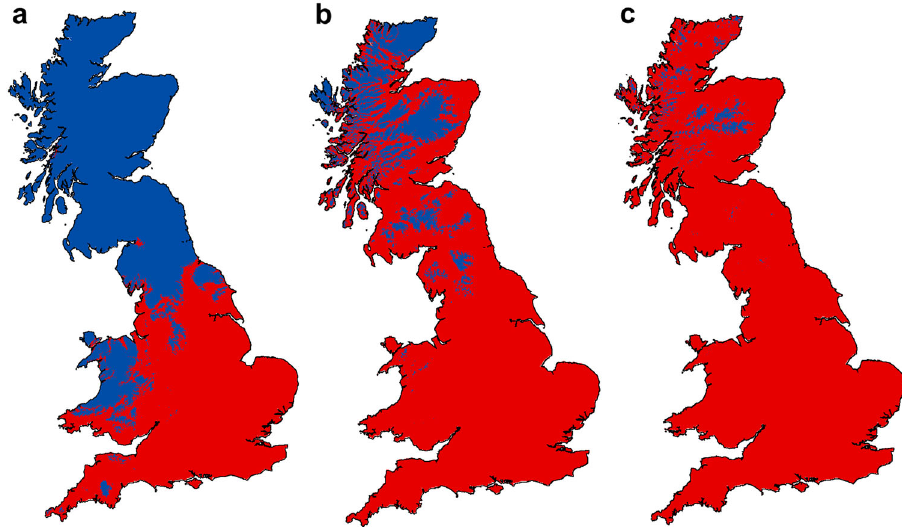
Fig. 3 Relative climate suitability for HbS and HbF. Blue colour indicates areas where climate is predicted to favour HbS over HbF, red colour indicates areas where climate is predicted to favour HbF over HbS. a Present climate. b , c Optimistic ( b ) and pessimistic ( c ) future climate scenarios. The fi gure was created using ArcMap (v.10.8) and the Esri world countries dataset